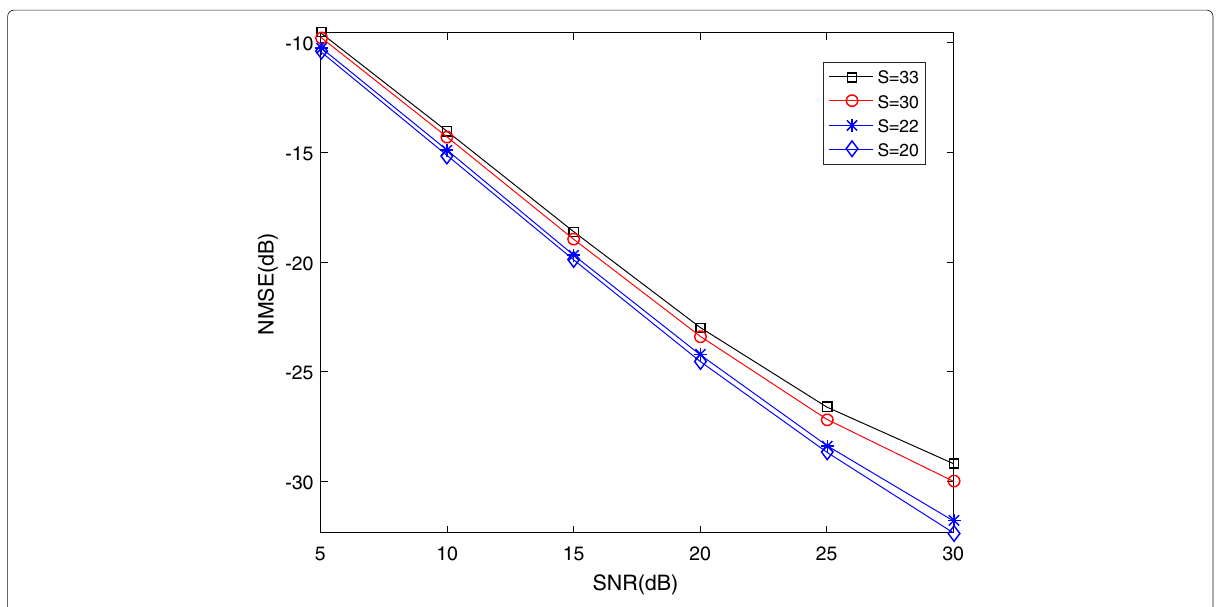
Fig. 5 NMSE of 2D-SL0-CE with various channel